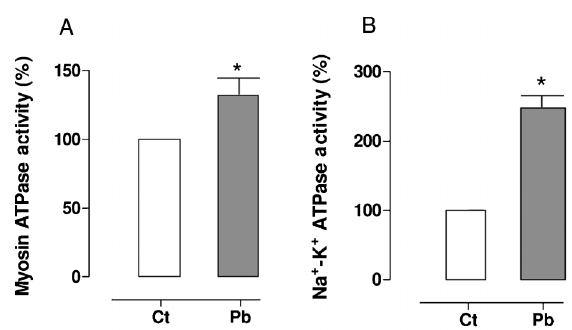
Figure 2. Effects of 8 m M lead acetate on the time course of peak force of isometric force upon tetanic stimulation. Results are reported as means ± SE for 8 animals. Ct = control. *P , 0.05 for lead vs Ct (one-way repeated measures ANOVA followed by the Tukey test).